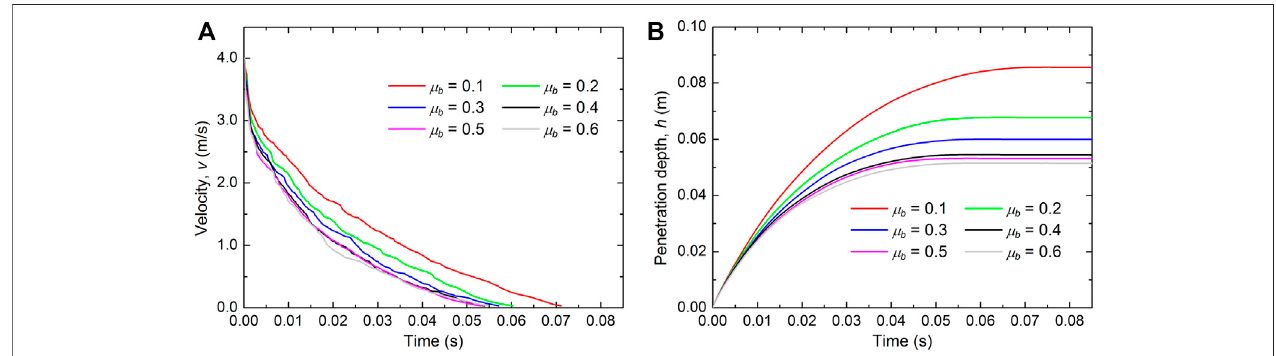
FIGURE 10 | Evolutions of (A) velocity and (B) penetration depth of projectiles for the numerical tests of various friction coef fi cients of bed particles (under the condition of v 0 = 4.0